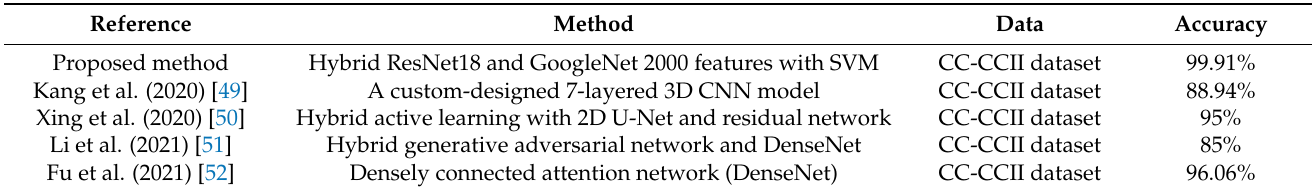
Table 6. Comparison of proposed method accuracy with the recent literature using the same